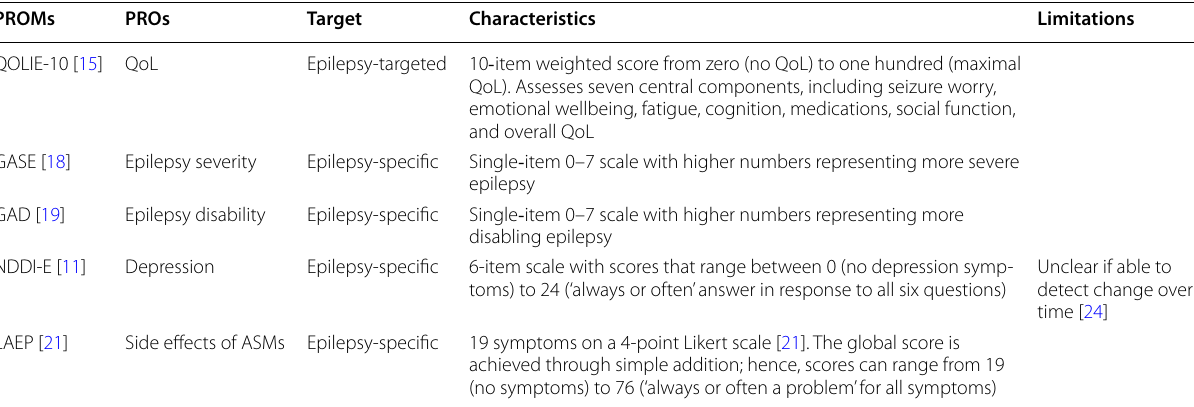
Table 3 CEP epilepsy‑specific/targeted PROMs, these are also available as ePROMs